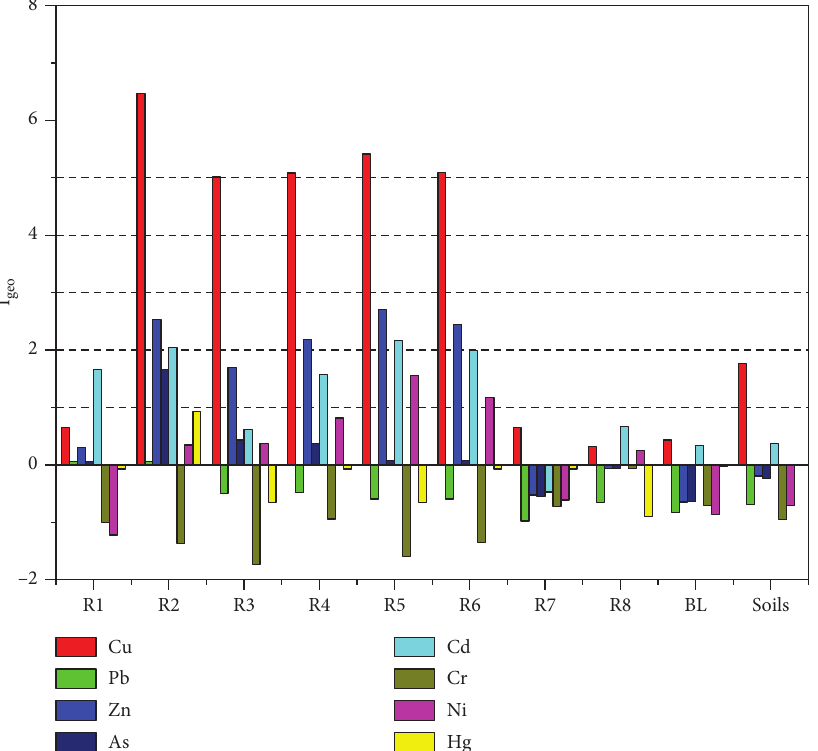
Figure 4: I Geo distribution of heavy metals in the study